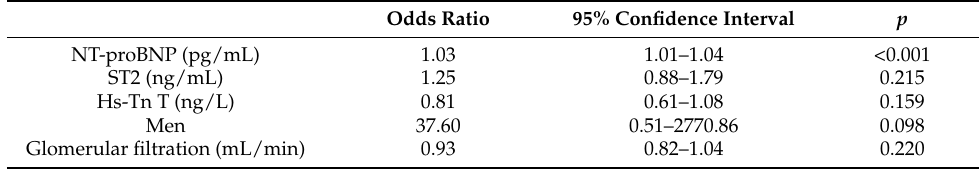
Table 3. Multivariate analysis. Odds Ratio 95% Confidence Interval p NT-proBNP